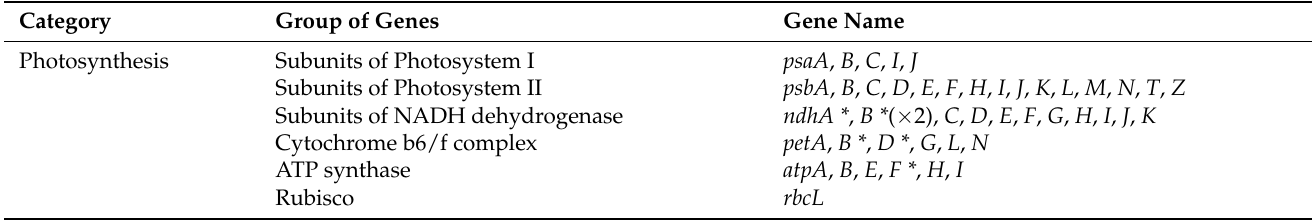
Table 2. List of annotated genes in the chloroplast genomes of three Ceriops species and Avicennia lanata